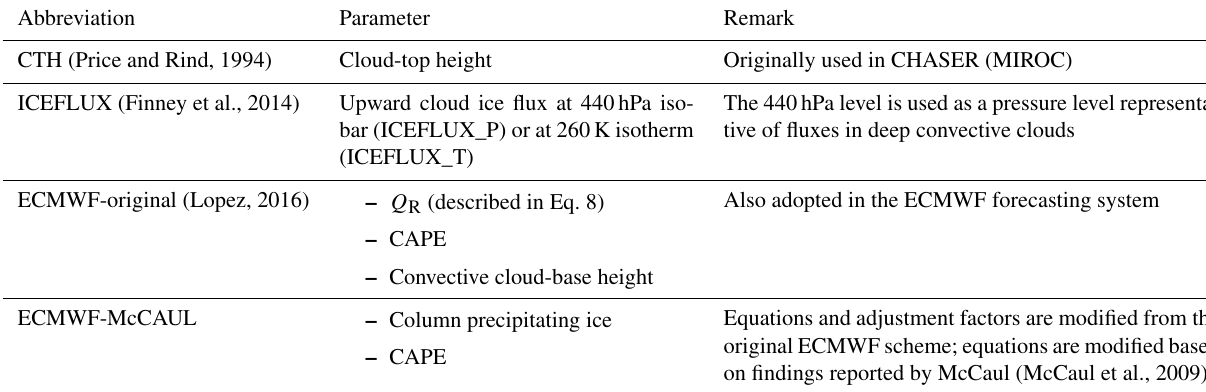
Table 1. Basic information on all lightning schemes assessed for this